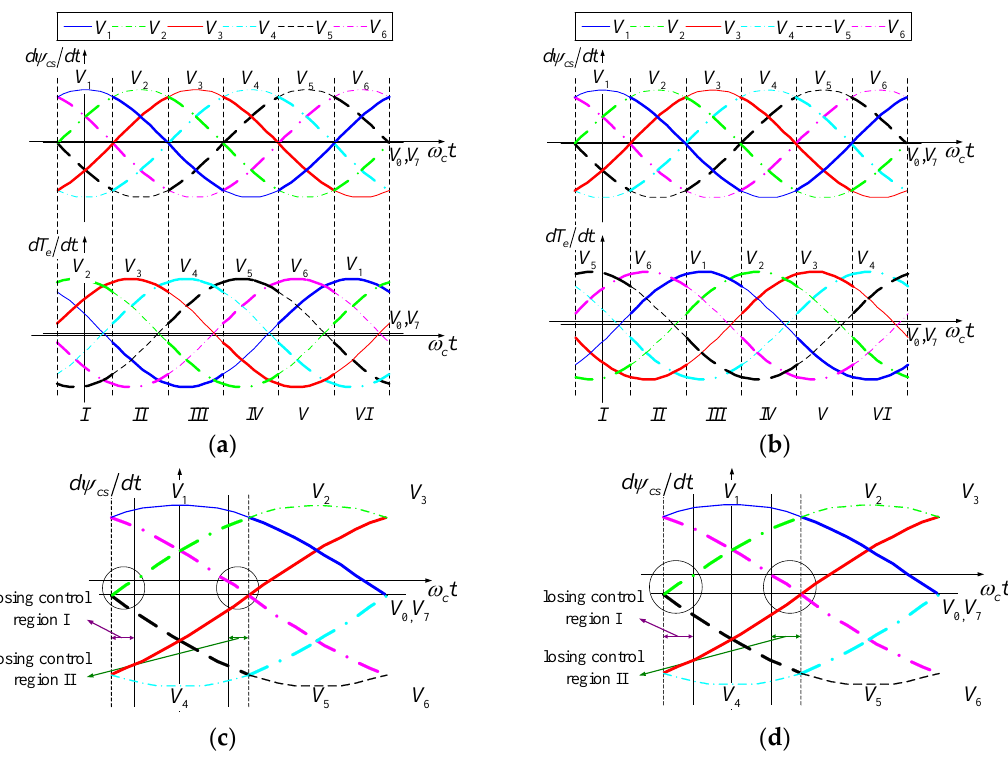
Figure 4. Stator flux of the CM and torque derivative curves (light load). ( a ) Motoring mode ( T e = 30 Nm); ( b ) Generating mode ( T e = −30 Nm); ( c ) Partial enlarged ( T e = 30 Nm); ( d ) Partial enlarged ( T e = −30 Nm).